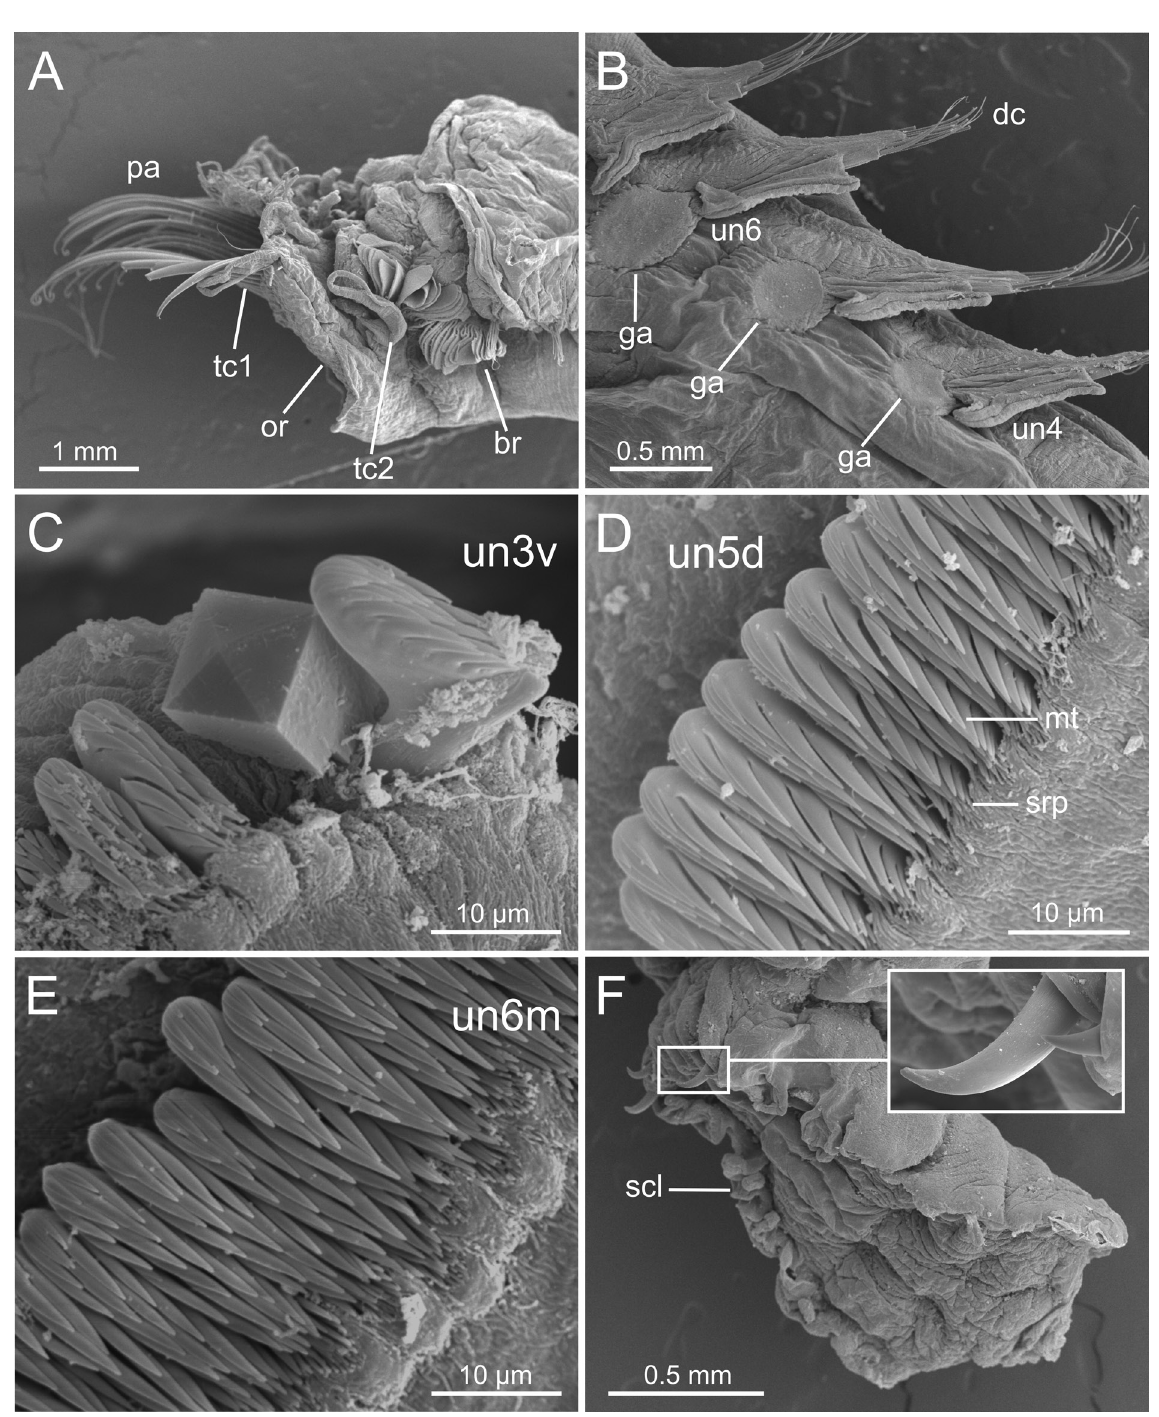
Fig. 16. Lagis koreni Malmgren, 1866. SEM micrographs from two specimens: large (A, F) and medium sized (B–E), respectively (BIOICE sample 2827, IINH-40485). A . Anterior end, right lateral view. B . Uncinigers 4 to 6, ventrolateral view. C . Unciniger 3, ventral uncini. D . Unciniger 5, dorsal